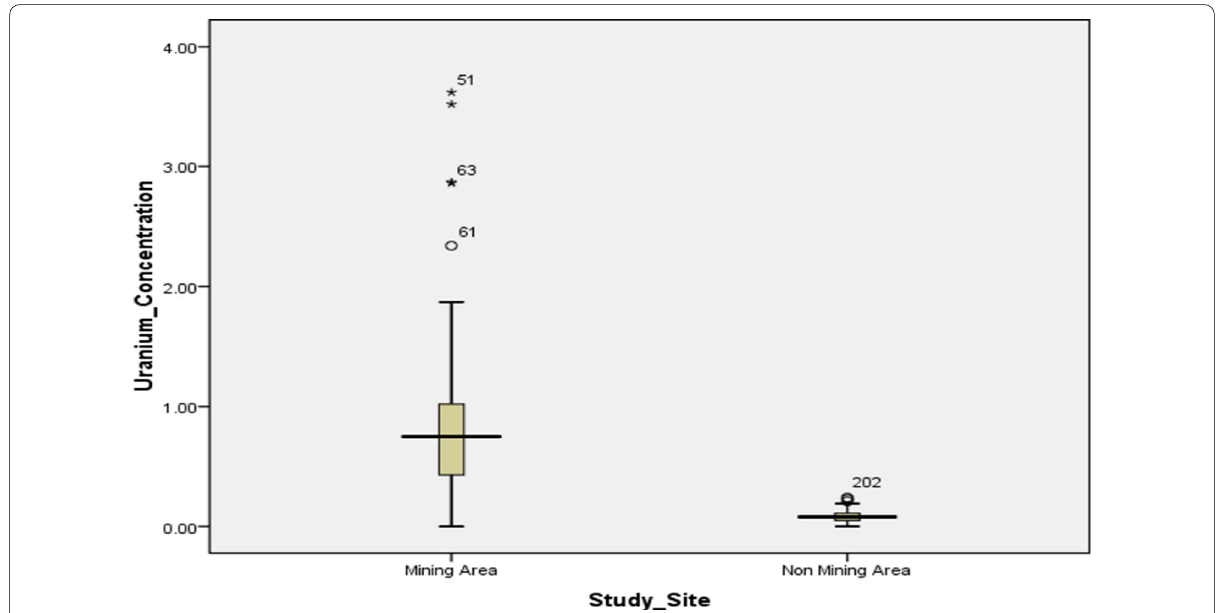
Fig. 3 Uranium concentrations levels in milk samples from the mining area and non-mining